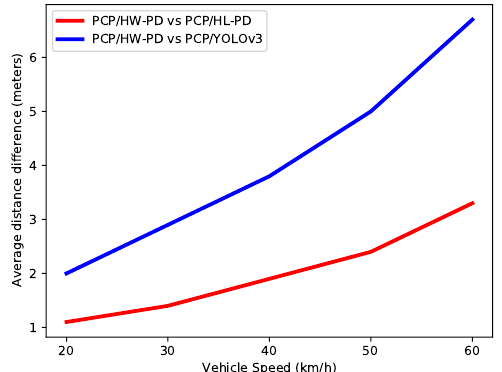
Figure 17. Average distance difference in meters for decision-making calculated from the results of all TTCs for each